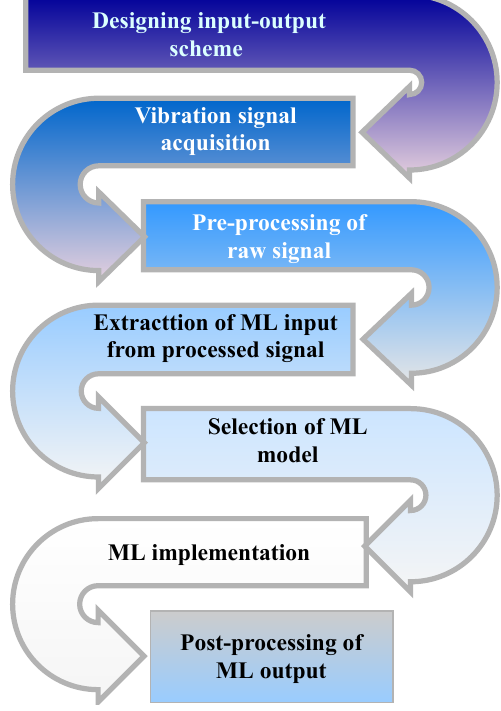
Figure 6. Procedures of training an ML algorithm. Table 18. Some studies on the application of supervised/unsupervised ML algorithms in structural damage-detection